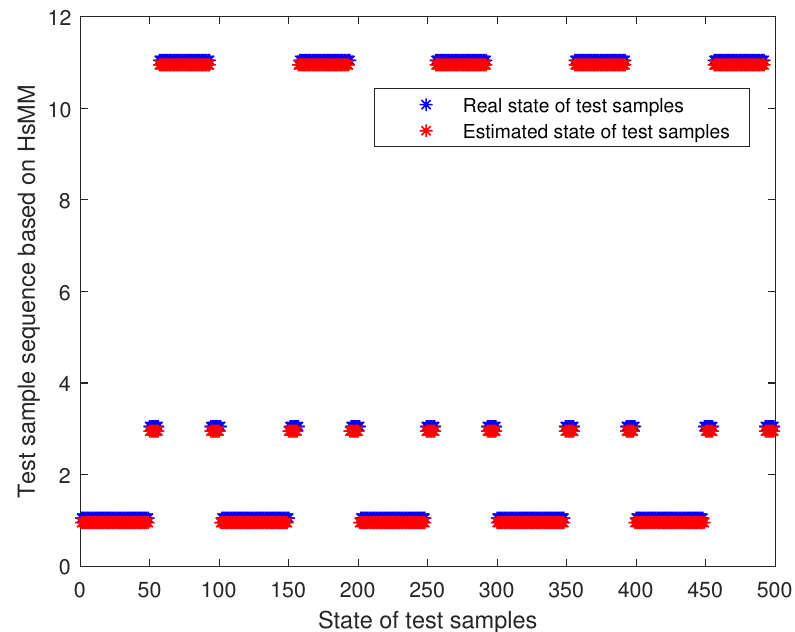
Figure 4. Comparison diagram of real state and estimated state of test samples based on HSMM when parameter D = 37.